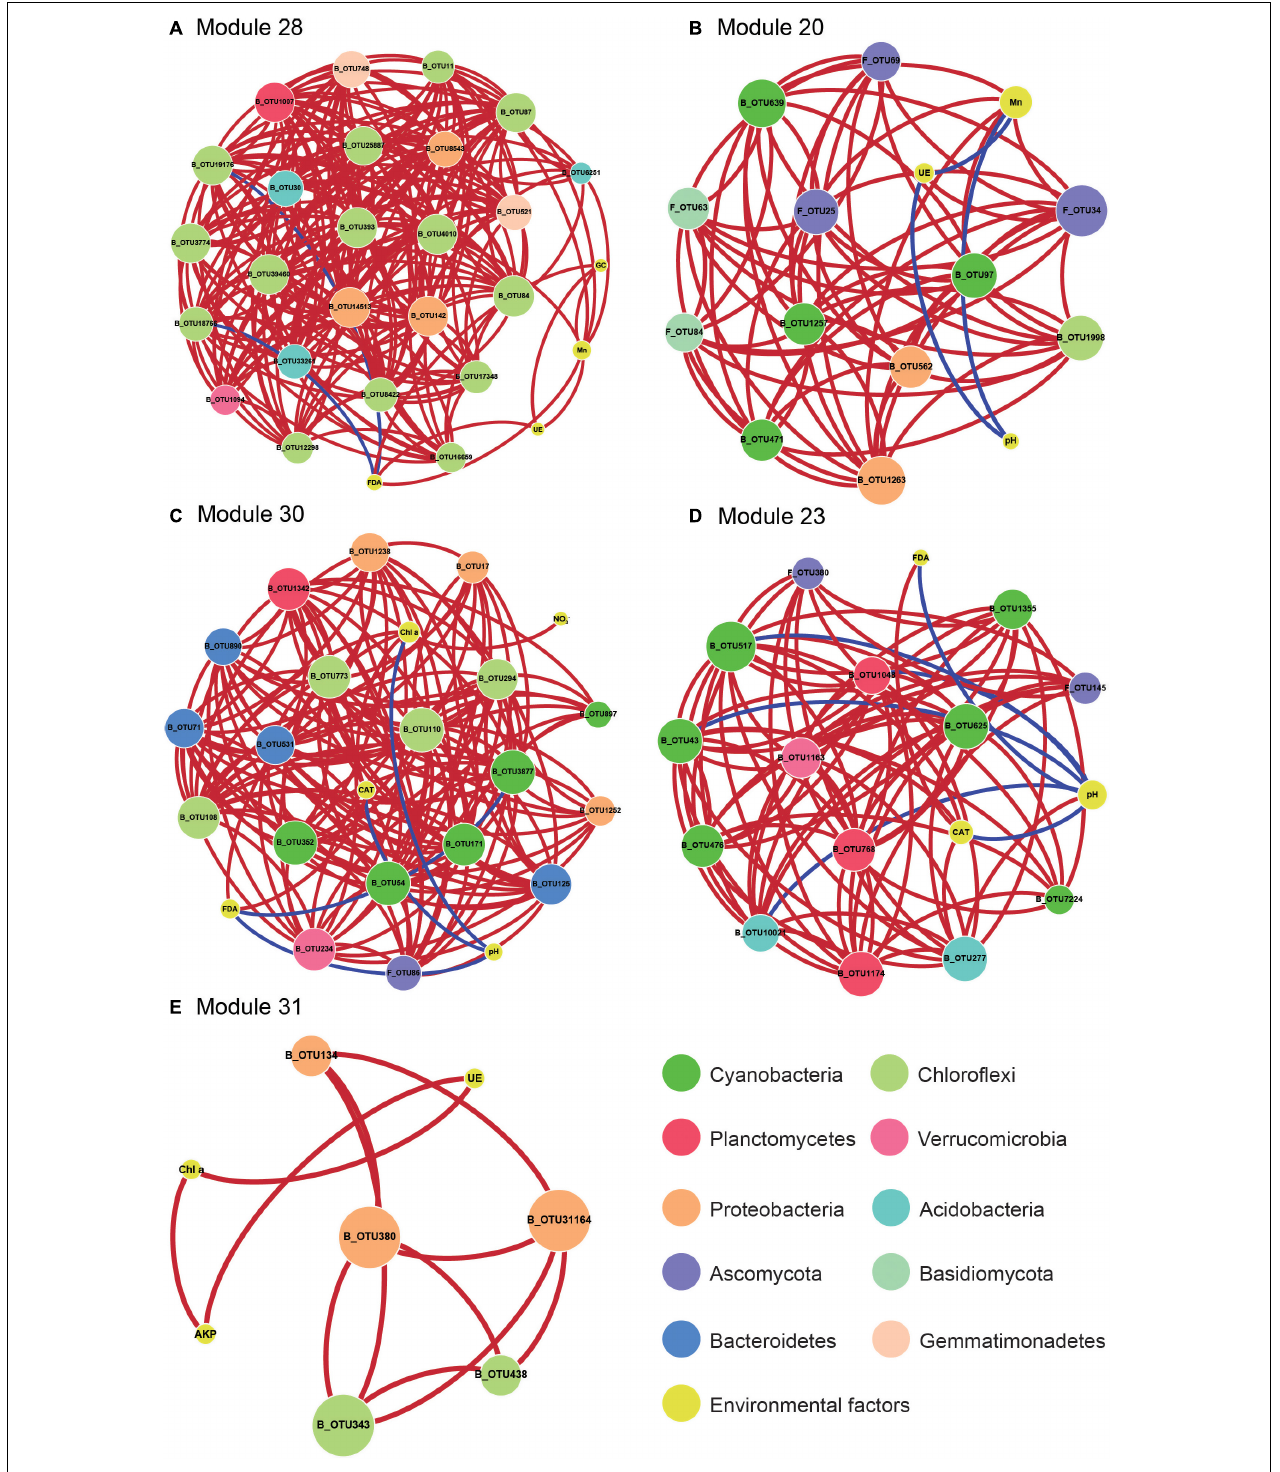
FIGURE 5 | The network analysis revealing the correlation of the key properties with the signature OTUs. A correlation between two items was considered statistically robust if the absolute value of Spearman’s correlation coefficient ( ρ ) was > 0.35 and the P < 0.05. The nodes were the signature OTUs and the key properties, which from microbial modules, module 28 (A) , module 20 (B) , module 30 (C) , module 23 (D) , and module 31 (E) . OTUs were colored according to OTUs classification information. The size of each node was proportional to the number of connections. Graphics were generated in Cytoscape 3.5.1 using a circular layout. Chl a , chlorophyll a ; GC, soil β -glucosidase activity; FDA, soil FDA hydrolase activity; UE, soil urease activity; CAT, soil catalase activity; NO 3 -N, soil nitrate nitrogen.